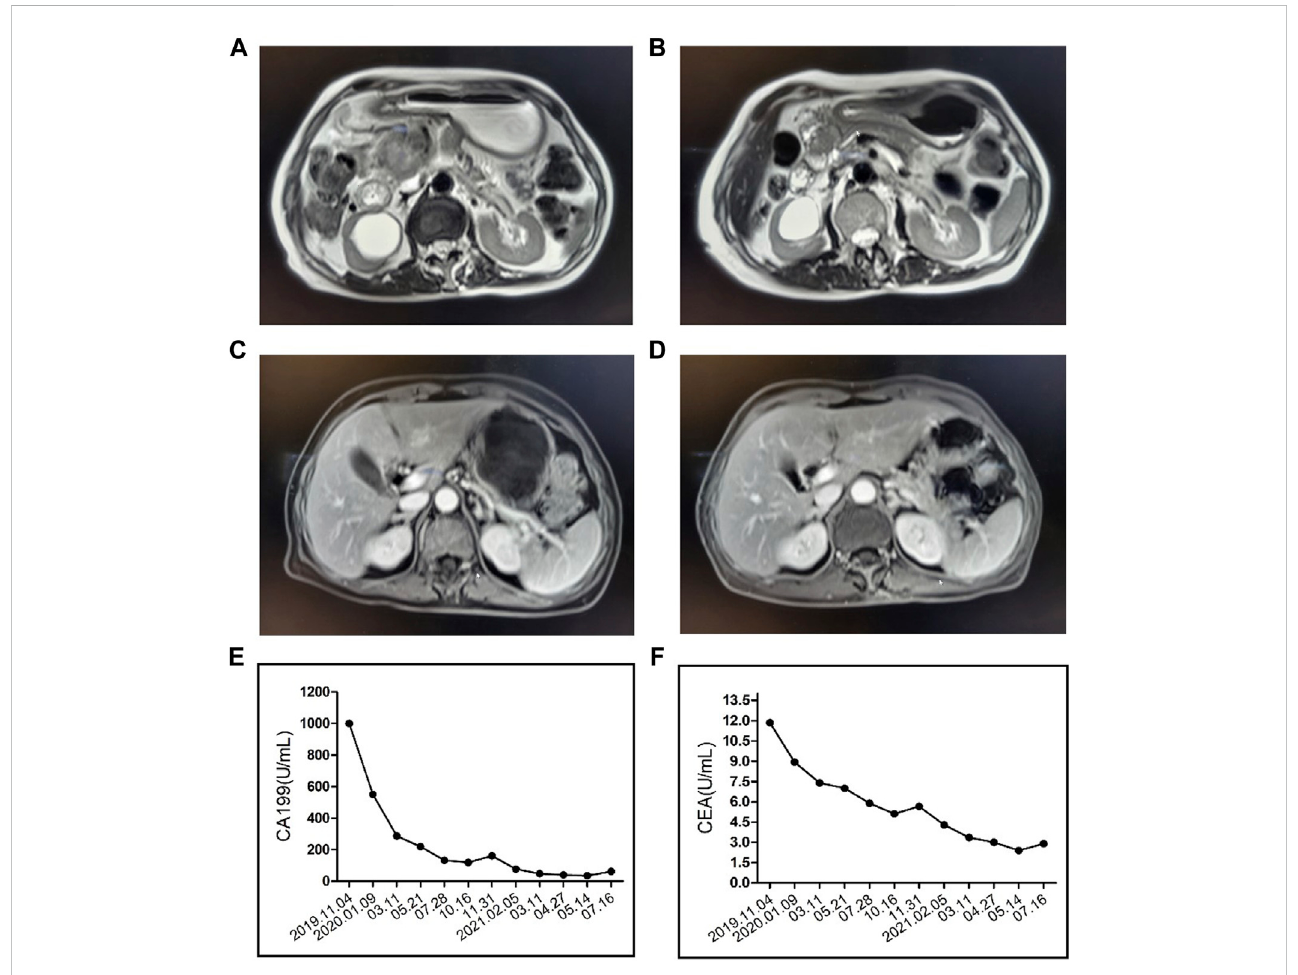
FIGURE 2 Contrast-enhanced Magnetic Resonance Imaging (MRI) of the upper abdomen showed the patient ’ s pancreatic carcinoma before (A) and after (B) the treatment of PD-1, HIFU and Gemcitabine. MRI showed the patient ’ s liver metastasis before (C) and after (D) the treatment. CA199 (E) and carcinoembryonic antigen (CEA) (F) index of the